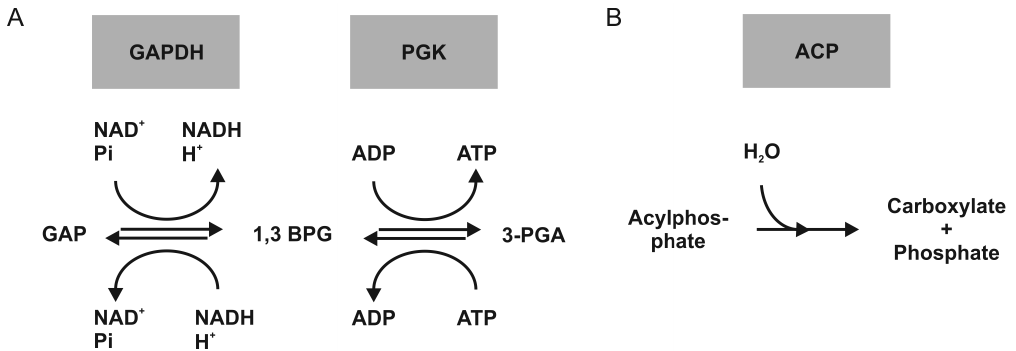
Figure 1. Reaction schemes for the tested enzymes. ( A ) Reactions in the glucose metabolism catalyzed by GAPDH and PGK. In the forward reaction for GAPDH, conversion of substrate GAP is monitored directly by changes in NADH concentration. In the forward reaction for PGK, conversion of substrate ADP is monitored in a linked assay with forward reaction of GAPDH as a source for 1,3 BPG. In the reverse reaction for PGK, conversion of 3-PGA is monitored by the changes in NADH concentration in a linked assay with 1,3 BPG as a substrate for GAPDH [22]. ( B ) Reaction catalyzed by ACP. Hydrolysis of acylphosphate leads to the formation of a carboxylate and an inorganic phosphate.